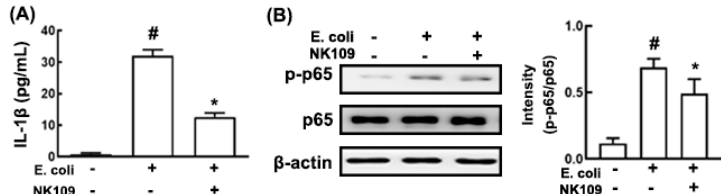
Figure 1. Effect of Lactobacillus gasseri NK109 on the Escherichia coli K1-induced interleukin (IL)-1 β and nuclear factor (NF)- κ B activation in macrophage cells. Effect on IL-1 β expression ( A ) and NF- κ B activation ( B ) on macrophage cells. Macrophage cells (1 × 10 6 / mL) isolated from the peritoneal cavity were incubated with NK109 (1 × 10 5 colony-forming units (CFUs)/mL) in the absence or presence of Escherichia coli K1 (1 × 10 5 CFUs / mL). Data values are described as mean ± standard deviation (SD) ( n = 4). # p < 0.05 vs. group not treated with E. coli alone. * p < 0.05 vs. group treated with E. coli alone.